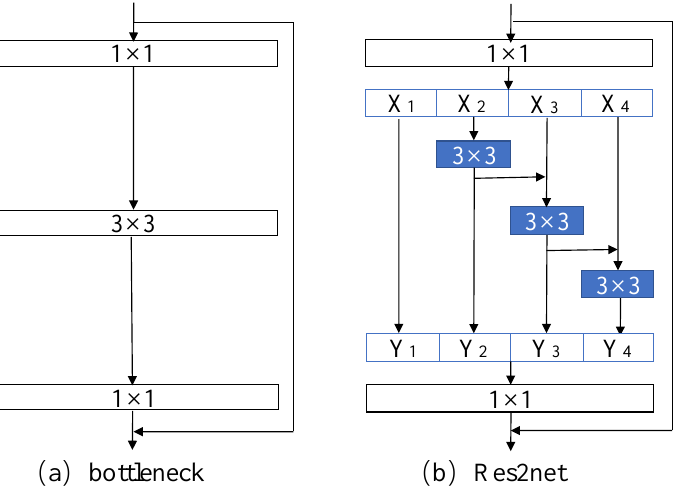
Figure 3. Compare the difference between ( a ) Bottleneck and ( b ) Res2net. Res2net represents more detailed multi-scale features, conducive to learning complex correlations between object categories and improving network prediction accuracy.